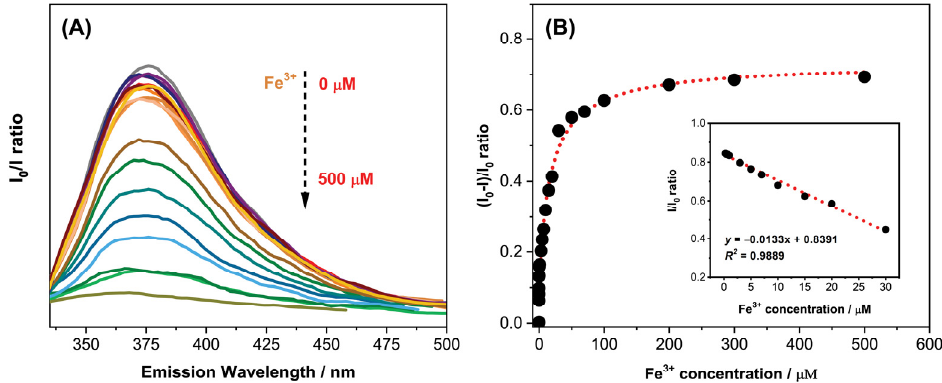
( D ) CQD@Lys, ( E ) CQD@Ala, ( F ) CQD@His.